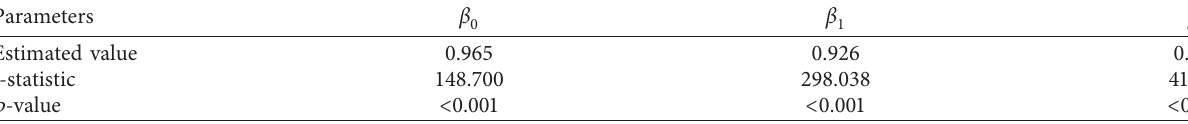
Table 3: Parameter estimations of boarding time model based on WLS.